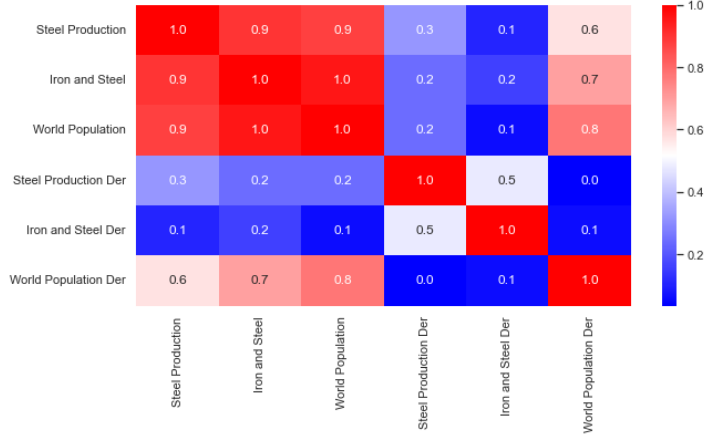
Figure 13. Correlation of the variables steel production, producer price index by commodity, world population, and their first derivates in time series.